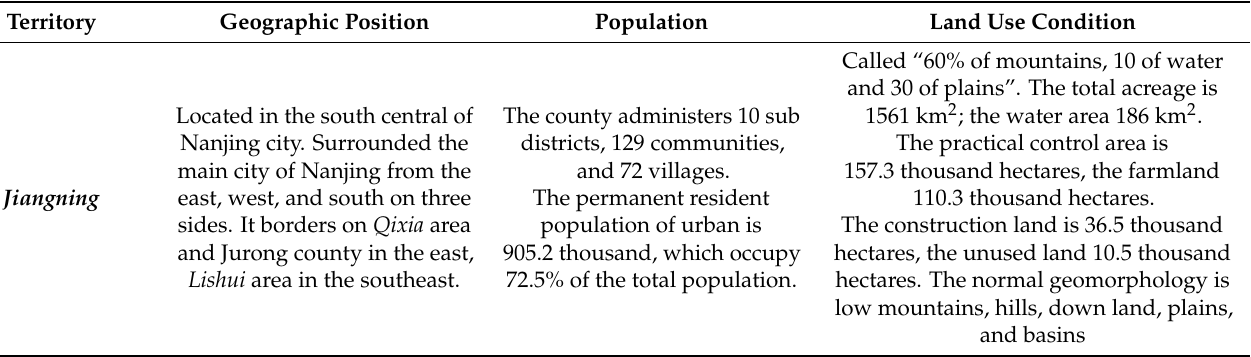
Table A3. Basic information on the research areas of Jiangning